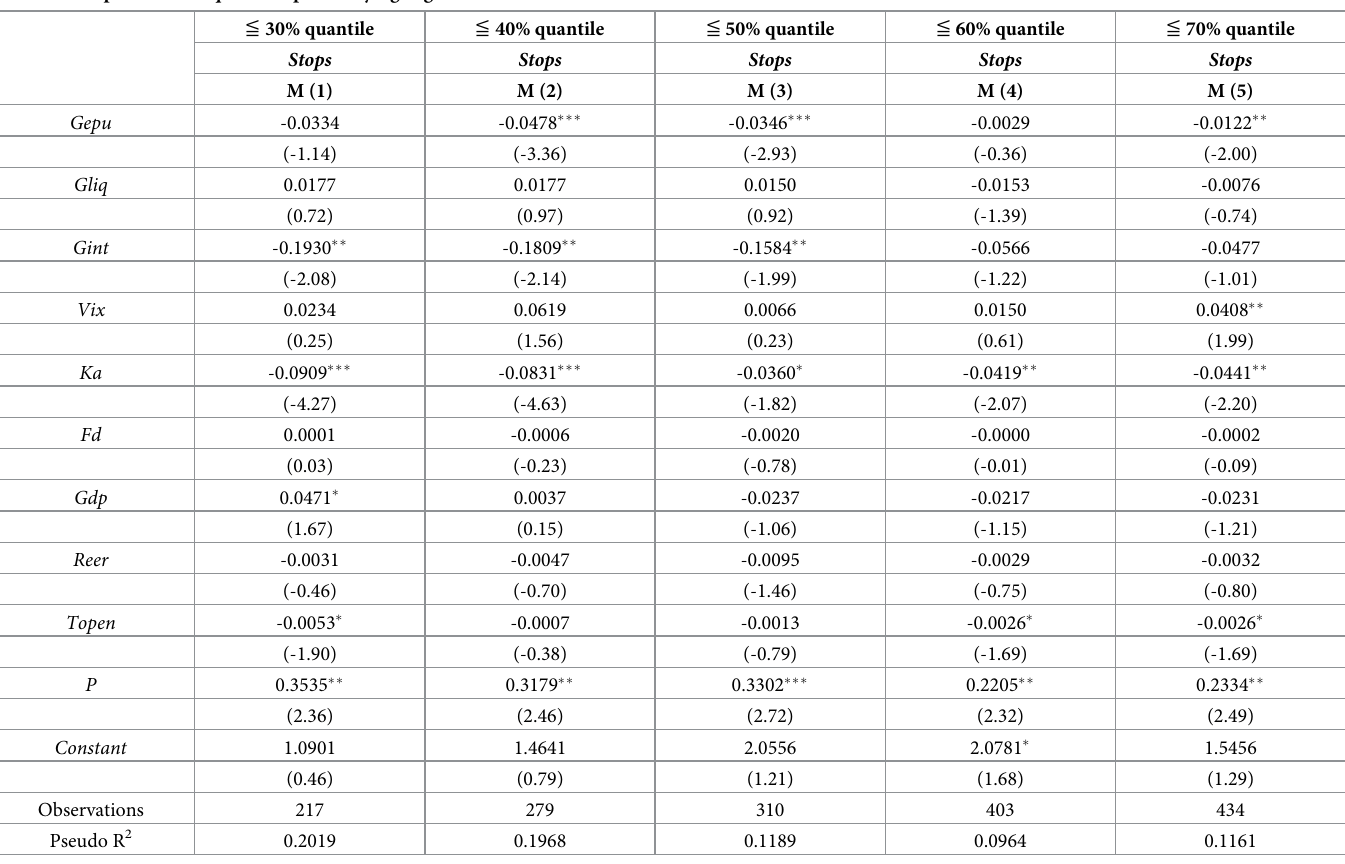
Table 12. Impact of the Gepu on stops to varying